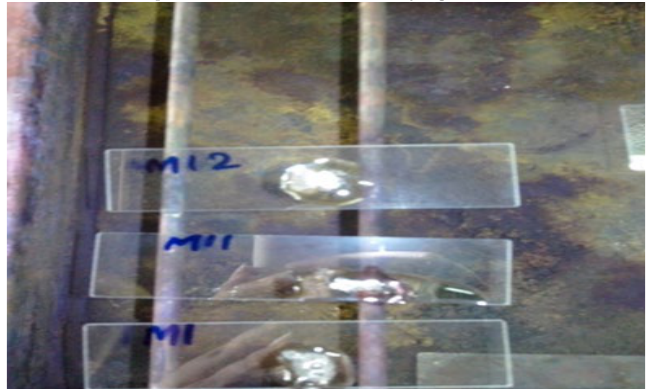
Catalase test was positive for the listeria